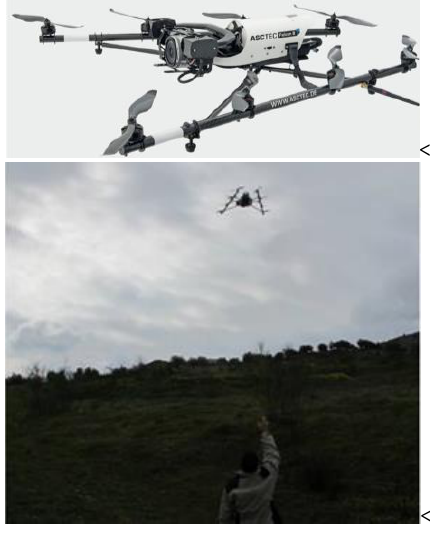
Figure 3. ASCTEC Falcon 8